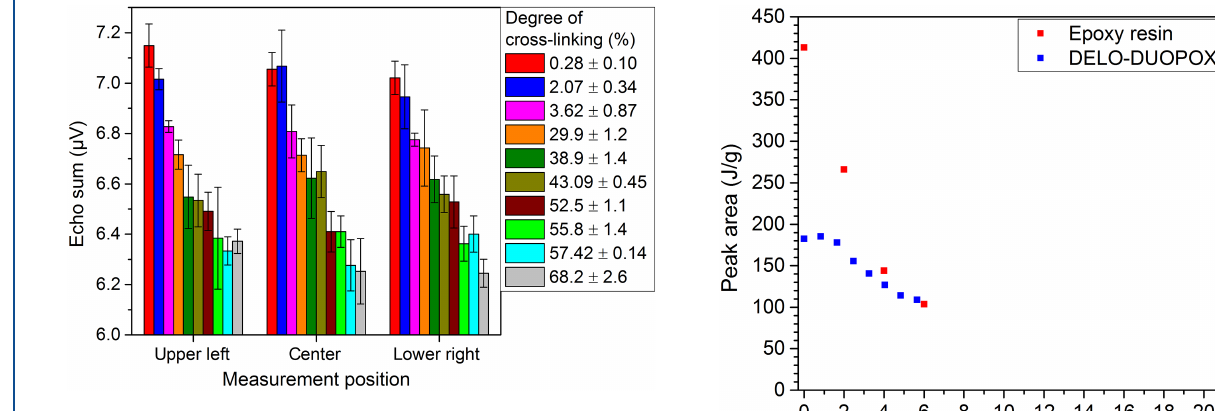
Figure 10. Echo sums from different measurement positions of PE- Xc samples.